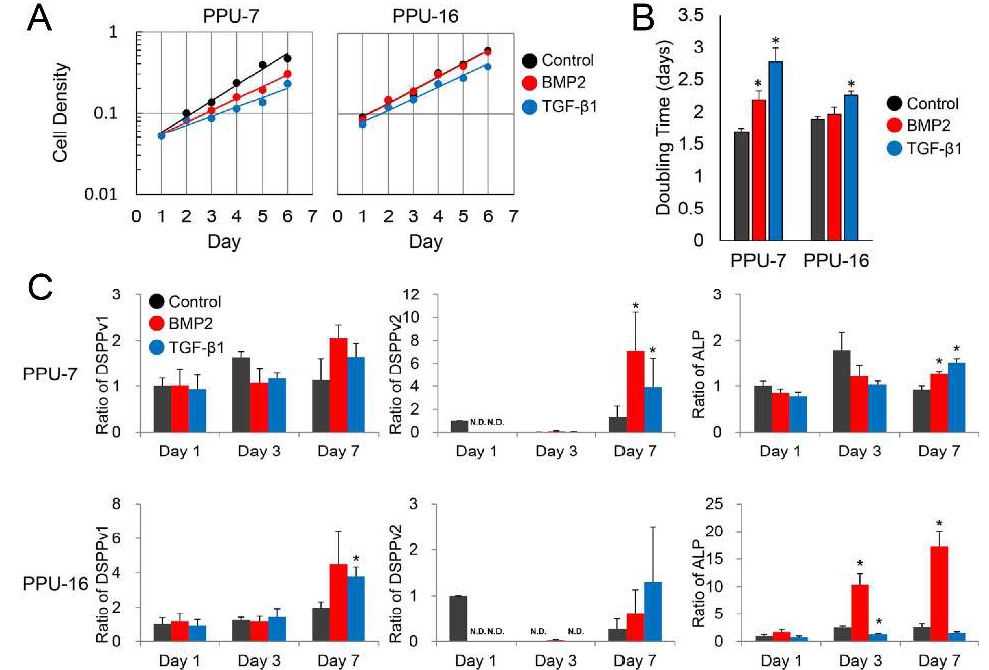
Figure A3. Effect of BMP2 and TGF- β 1 on proliferation and gene expression of PPU-7 and PPU-16 cell lines. ( A ) Cell density plotted on a semi-logarithmic scale was used to judge the logarithmic growth phase by linearity, which was determined, in turn, every day for 6 days. ( B ) Cell population doubling level against days in culture following transfection. Data are means ± standard error (SEM) of 6 culture wells. BMP2 and TGF- β 1 in PPU-7 or BMP2 in PPU-16 significantly required time (* p < 0.05). ( C ) The mRNA expression by qPCR analysis of DSPP-variant 1 (DSPP-v1, left), DSPP-variant 2 (DSPP-v2, middle), and ALP (right). Each ratio was normalized to glyceraldehyde-3-phosphate dehydrogenase (GAPDH) as a reference gene, and the relative quantification data of DSPP-v1, DSPP-v2, and ALP in PPU-7 or PPU-16 were generated on the basis of a mathematical model for relative quantification in a qPCR system ( n = 6 PPU-7 or PPU-16). All expression levels are indicated as the increasing or decreasing ratio, when the mRNA level of control (Day 1) was 1. Data are means ± standard error (SEM) (* p < 0.05). N.D.: not